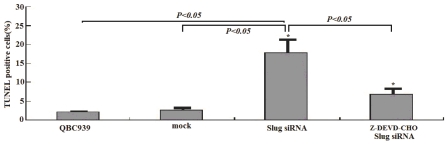
TUNEL staining was performed for QBC939 cells transiently transfected with Slug siRNA or mock transfected for 48hs. Green nuclear staining indicates apoptotic cells. The percentage of TUNEL-positive cells was quantified. Columns and bars represent the mean and standard deviation of three independent determinations, respectively. Significant differences between the controls (mock) and the Slug siRNA groups are indicated by *P < 0.05.